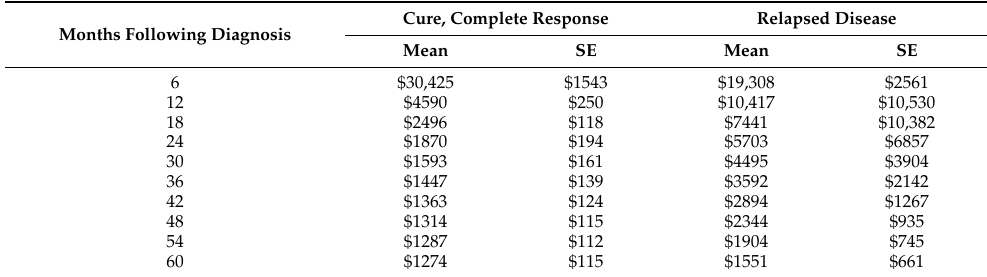
Table A1. Mean Cost of Treatment for Cure, Complete Response and Relapsed Disease Health States (Standard